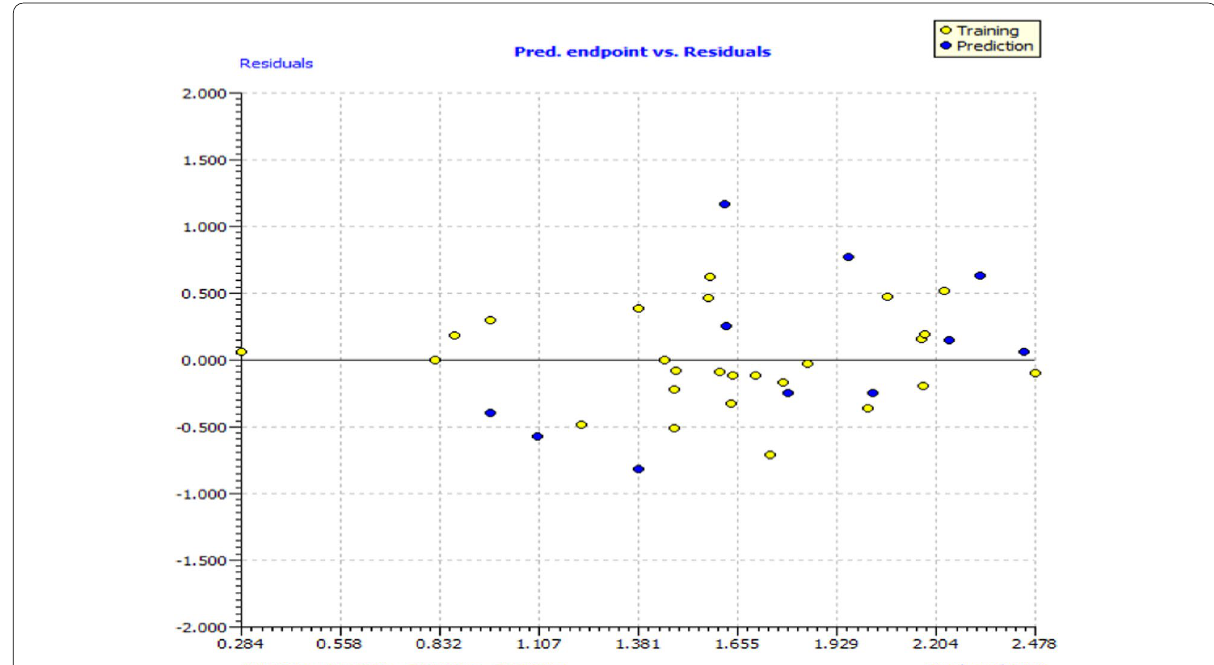
Fig. 4 Experimental data versus